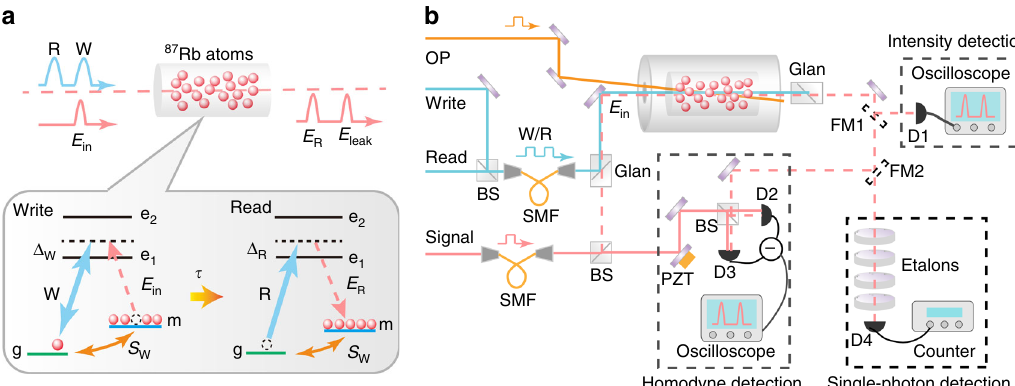
Fig. 1 Raman memory. a Schematic, atomic energy levels and frequencies of the optical fi elds. | g , m 〉 : hyper fi ne levels |5 2 S 1/2 , F = 1, 2 〉 ; | e 1 〉 and | e 2 〉 : excited states |5 2 P 1/2 , F = 2 〉 and |5 2 P 3/2 〉 . W write fi eld, E in input signal, E leak leaked signal, S W collective atomic spin wave, R read fi eld, E R retrieved signal. b Experimental setup. The polarizations of the weak signal beams, E in and E R , are perpendicular to the strong driving beams, W and R. The signals can be detected by homodyne detection. OP optical pumping laser, SMF single-mode fi ber, BS beam splitter, PZT piezoelectric transducer. D1 photo-detector, D2 and D3 photo-diode, D4 single-photon detector, FM1 and FM2 fl ip mirror. The fl ip mirrors FM1,2 allow alternative selection of detections via intensity, homodyne, and single photon. Intensity detection is chosen to calibrate the memory ef fi ciency by fl ipping FM1 up, homodyne detection combining with tomography reconstruction to determine the memory fi delity by fl ipping FM1 down and FM2 up, and single-photon detection to measure and analyze the excess noise in storage process by fl ipping FM1,2 both